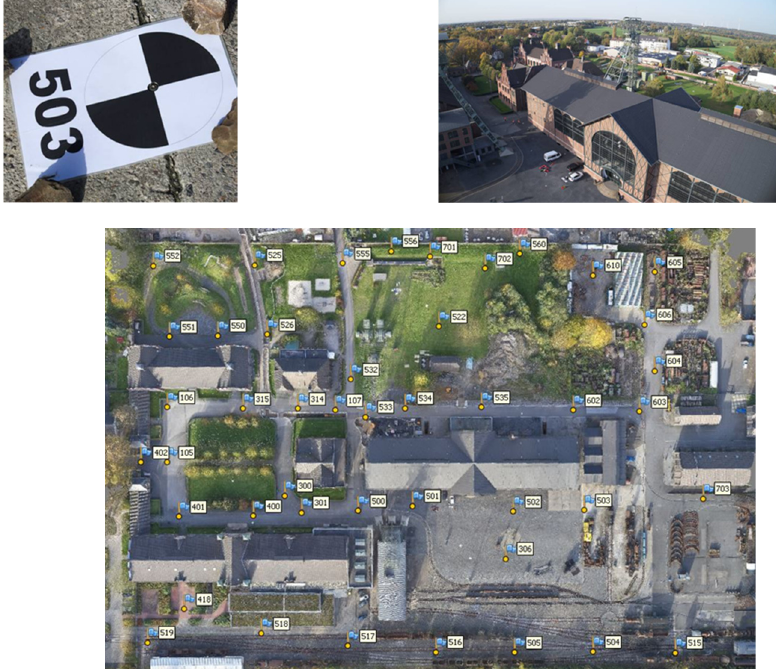
Figure 2. UAV test field Zollern colliery. Top: Target for signalizing the GCPs and the view of the area. Bottom: Point cloud with signalized GCPs (UAV flight from October